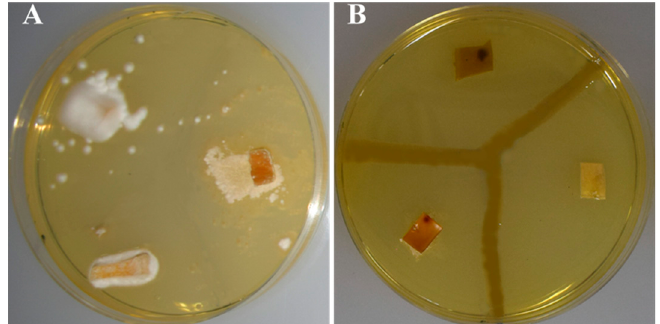
Figure 4. Antibiosis assays against bark beetle fungal pathogens. ( A ) Control plate with fungal plugs and no bacteria. ( B ) Plate streaked with strain C2L11. In ( A , B ), superior left plug corresponds to Beauveria bassiana CCF5554, right plug is Lecanicillium muscarium CCF6041, and inferior left is Isaria farinosa CCF4808. Table 5. Antagonism test of P. typographi strains against the entomopathogen fungi: Lecanicillium